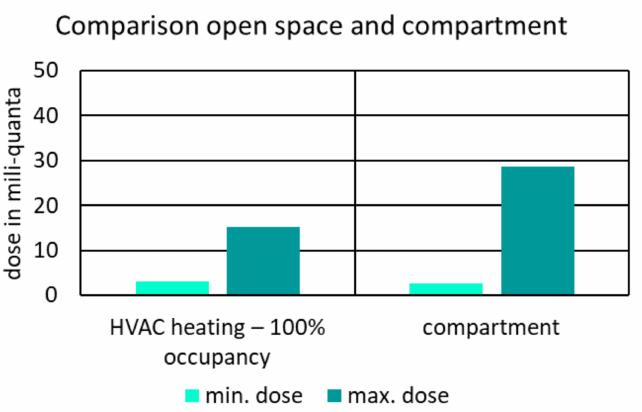
Figure 12. Concentration distribution in mili-quanta/m 3 for the case “Speaking loudly, without mask” in the ICE with compartment formation around the emitter.